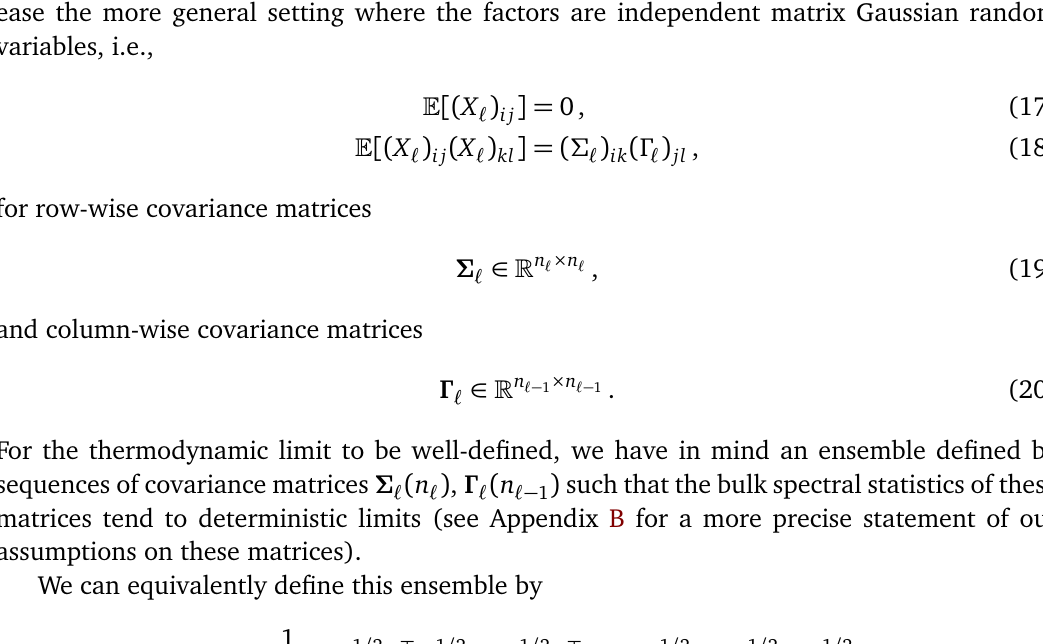
Figure 1: Eigenvalue densities for unstructured Wishart product matrices for depths L = 1 ( left ) and L = 2 ( right ) for varying widths α shades of red. Solid lines show the result of solving equation (15) numerically, while shaded areas show the results of numerical eigendecompositions of matrices of size = 2048. Importantly, each empirical histogram is obtained for a single realization n 0 of the random